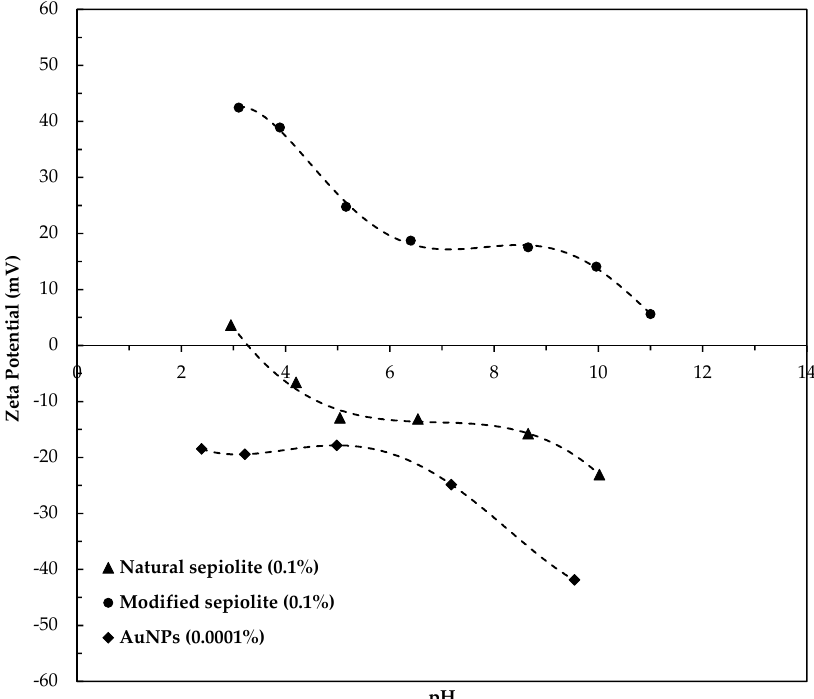
Figure 2. Zeta potentials of natural sepiolite (NS), modified sepiolite (MS), and AuNPs as a function of pH.